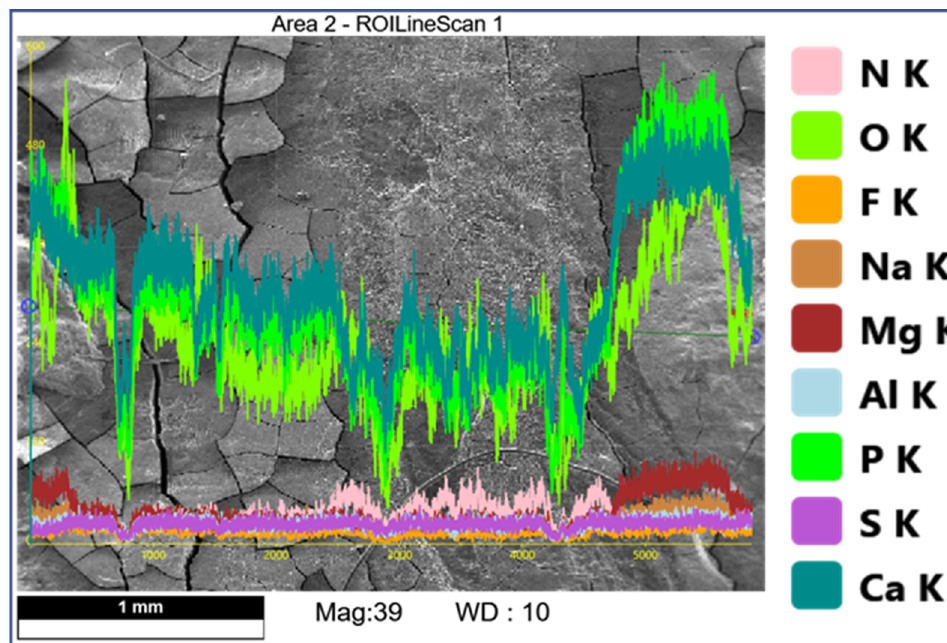
Figure 11. SEM of SRP + EDTA specimen with overlay of color-coded EDS line scan showing peaks (from baseline) for F, S, N, Na, Mg, Ca, P, and O. Compared to Figure 9, this scan shows obvious differences in location and presence of N, Na, and Mg. The scan started and stopped on calculus deposits with an intervening area of SRP in between. The scan traversed a line of ≈ 3 mm in length. Original mag. 39×; Bar = 1 mm. Working distance of 10 mm.